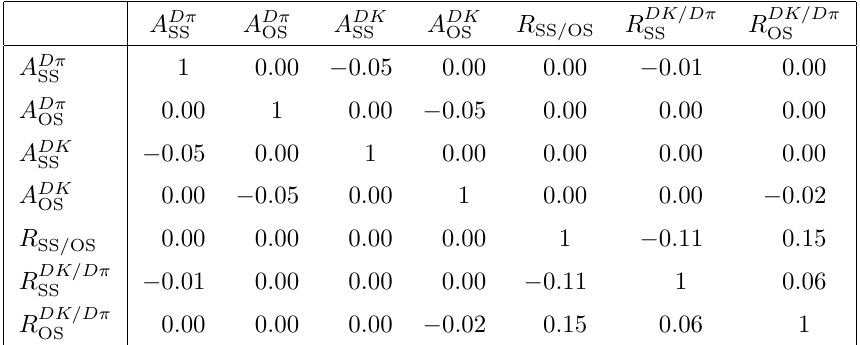
Table 4 . Statistical correlation matrix for the restricted K (cid:3) (892) (cid:6) region (cid:12)t.